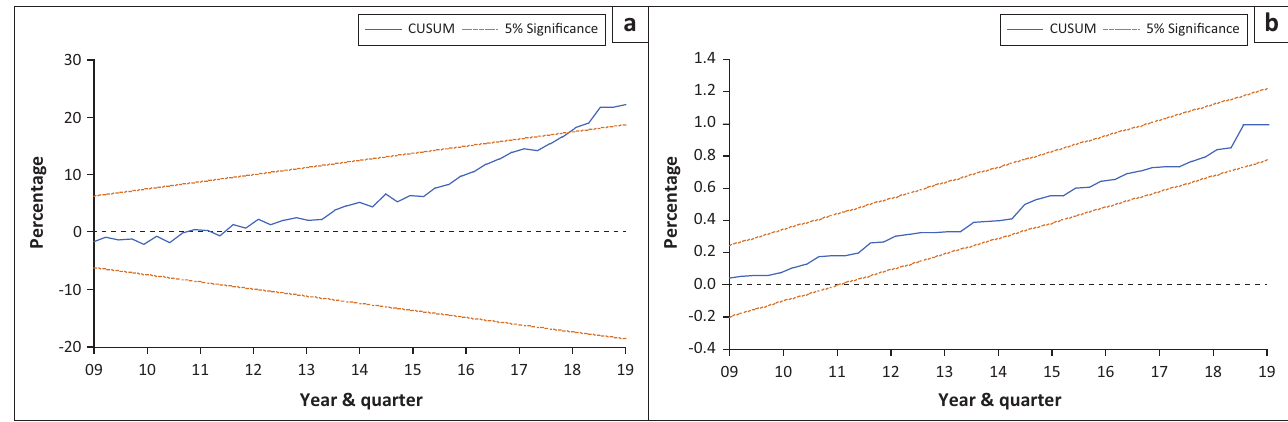
FIGURE 3: Stability test (a–b) for the unemployment-budget deficit TABLE 5: Autoregressive distributed lag block exogeneity causality tests. Hypothesis F -stat [ p -value]